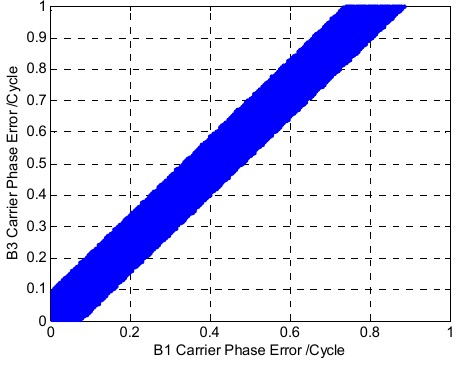
Figure 5. The DDGF detection failure area.